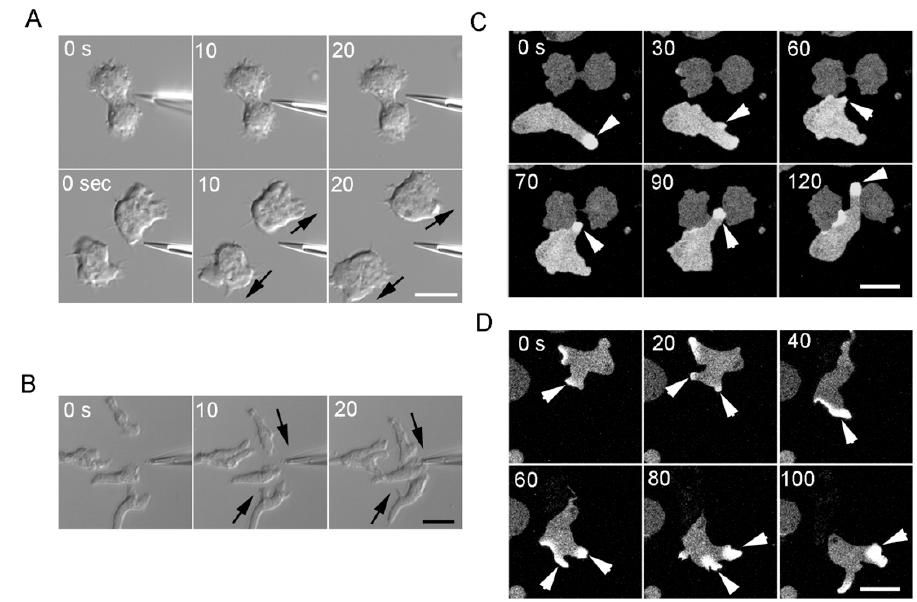
Figure 2. Midwife cells do not respond to the fluid collected near a dividing cell. ( A ) When fluid from the vicinity of the cleavage furrow of a dividing cell was aspirated with a micropipette (upper panels) and discharged near interphase cells (lower panels), the interphase cells neither extended a directed pseudopod nor followed the micropipette (n = 51). ( B ) As a control, when a micropipette containing 10 µM cAMP was applied to developed cells, they migrated toward the micropipette. ( C ) The GFP–PH domain (arrowheads) localized at the leading edge of migrating midwife cells toward a dividing cell. ( D ) The GFP–PH domain (arrowheads) localized at the leading edge of freely migrating vegetative cells. Bars, 10 µm.